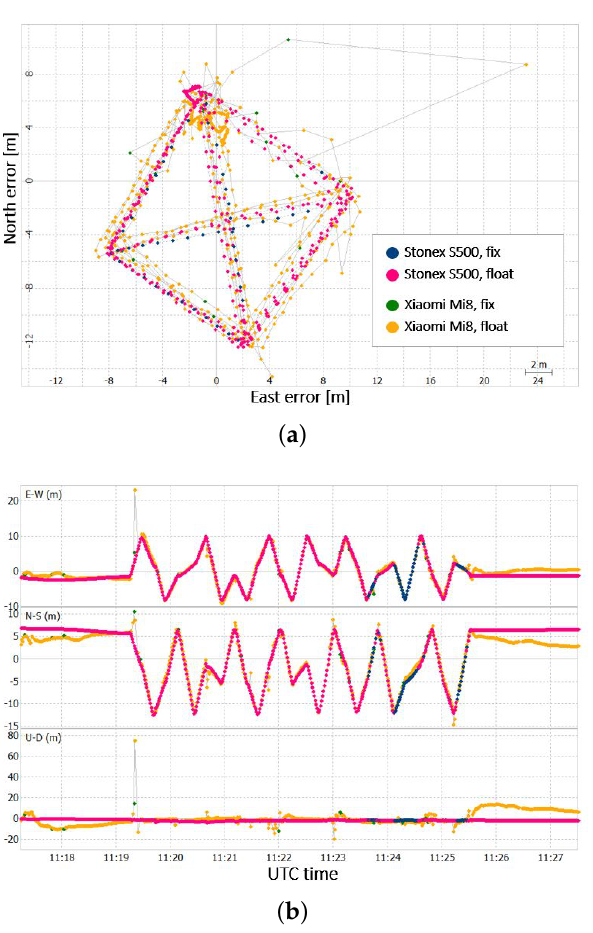
Figure 5. ( a ) Scatter plot of the positioning result for Xiaomi Mi8 and Stonex S500, and ( b ) time series of the positioning error for Xiaomi Mi8 and Stonex S500.